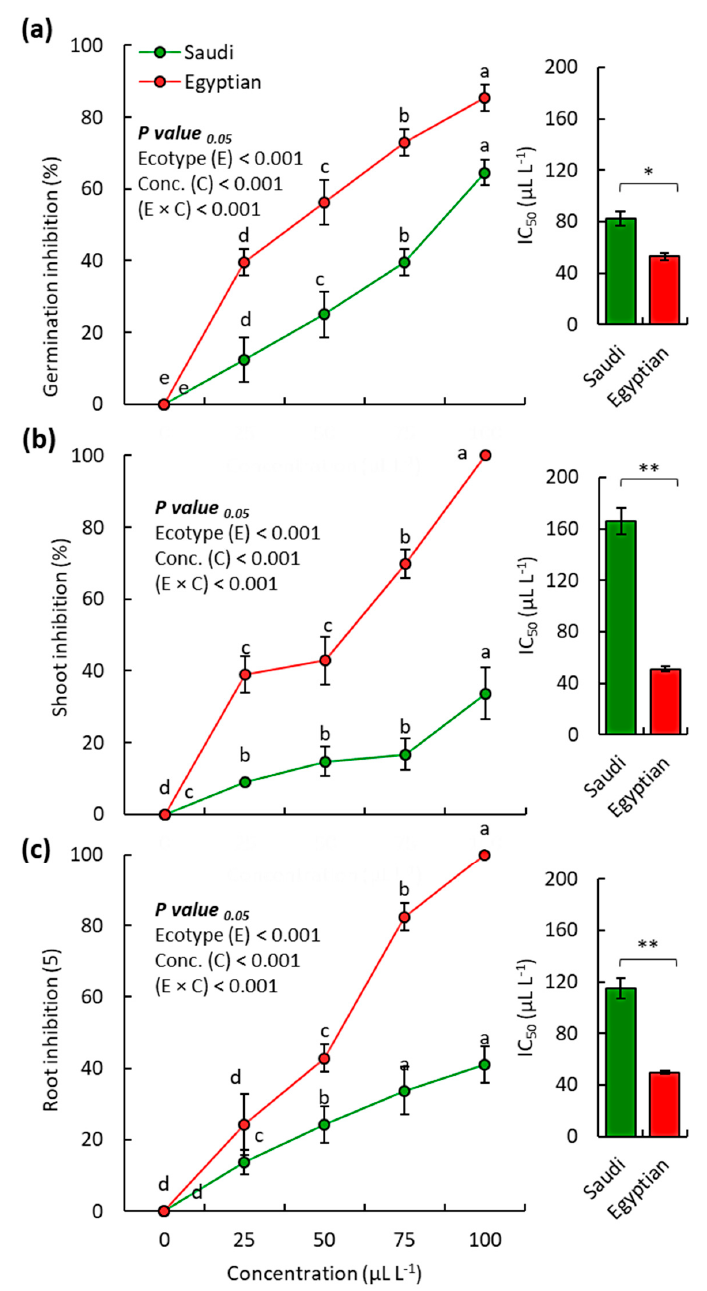
Figure 4. Phytotoxic activity of the EO from Saudi and Egyptian ecotypes of C. procera on the ( a ) seed germination, ( b ) seedling shoot growth, and ( c ) seedling root growth of D. aegyptium . * p < 0.05 , ** p < 0.01 (two ‐ tailed t ‐ test). Different letters per each line mean significant difference (one ‐ way randomized blocks ANOVA). Data are mean value ( n = 3) and the bars represent the standard error.